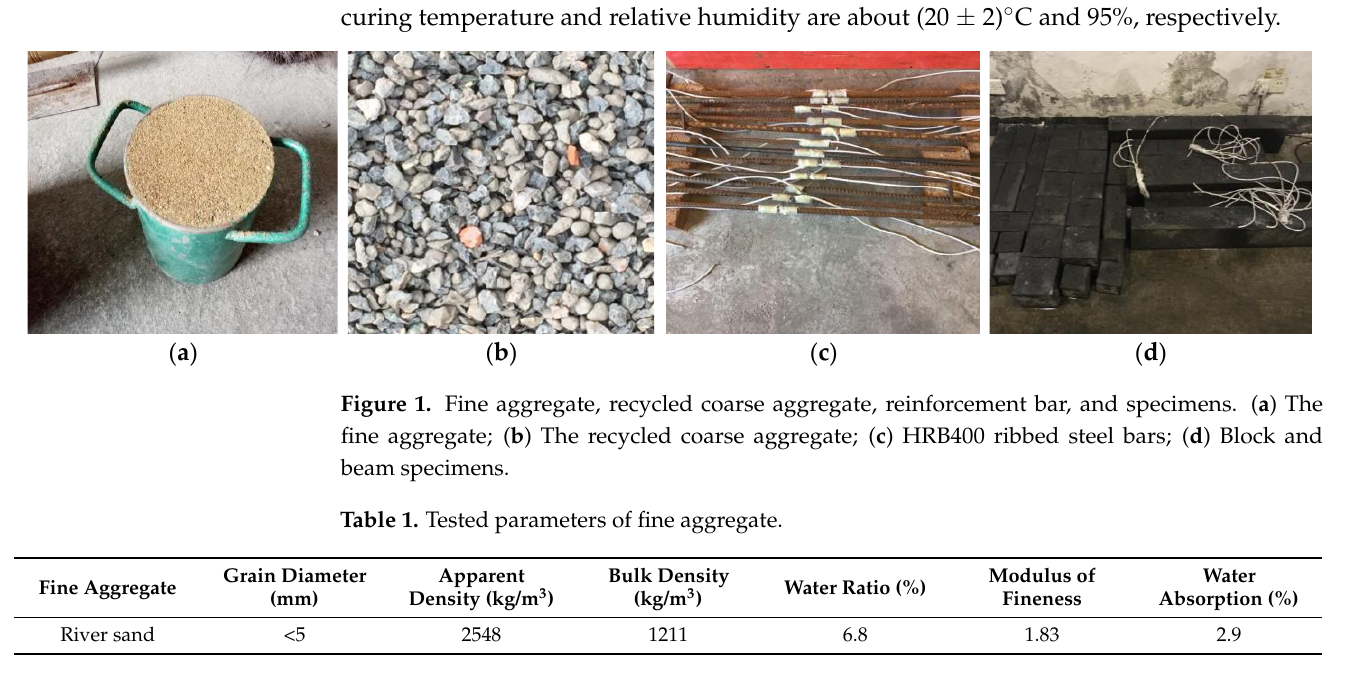
Table 2. Tested parameters of recycled coarse aggregate.